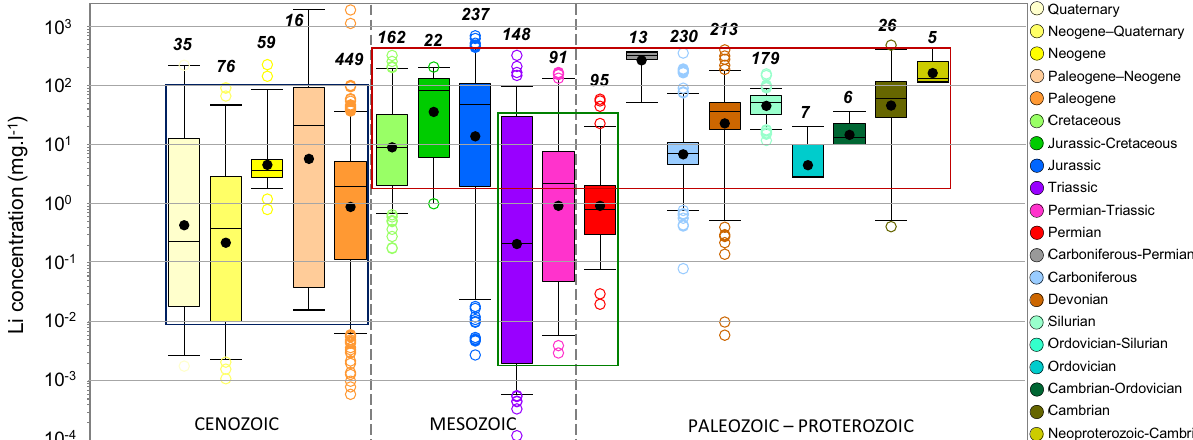
Figure 4. Lithium concentration in formation waters from sedimentary basins worldwide as a function of the age of the host reservoirs. The numbers in black and italics refer to the number of data. Lower whiskers, bottoms of boxes, central lines, circles, tops of boxes and upper whiskers represent 5th, 25th, 50th, average, 75th and 95th percentiles, respectively; circles below and above the whiskers represent outliers. The significances of colored squares are discussed in the lithium geochemistry in sedimentary formation waters section.